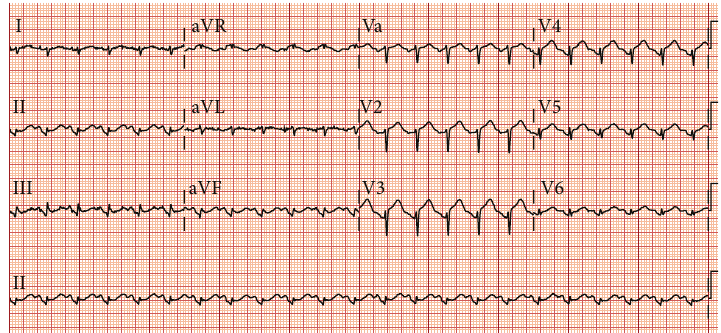
Figure 1: Initial ECG on presentation showing ST-segment elevation in leads V2 to V4, II, III, and aVF.